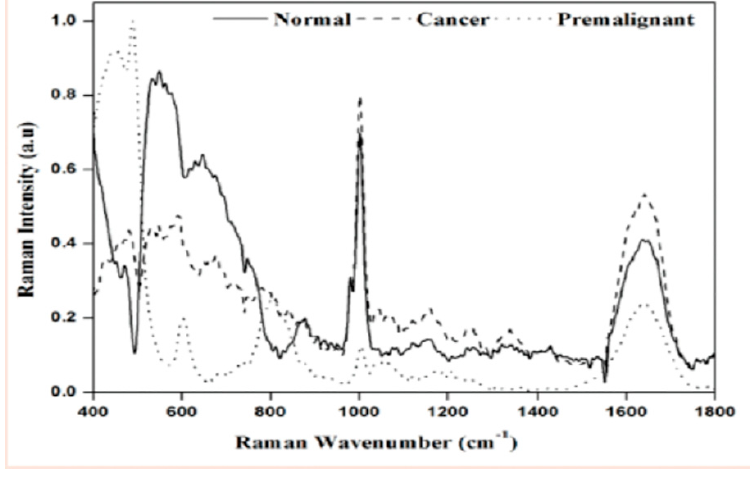
Figure 2. Raman spectroscopic intensity variations and peak shift among urine samples of three groups [85].